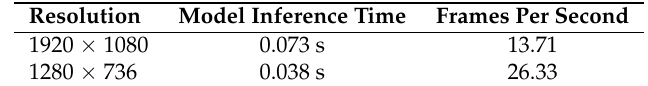
Table 7. Performance of the Early Fusion Network on a Nvidia GTX 1080 Ti 11GB (single forward